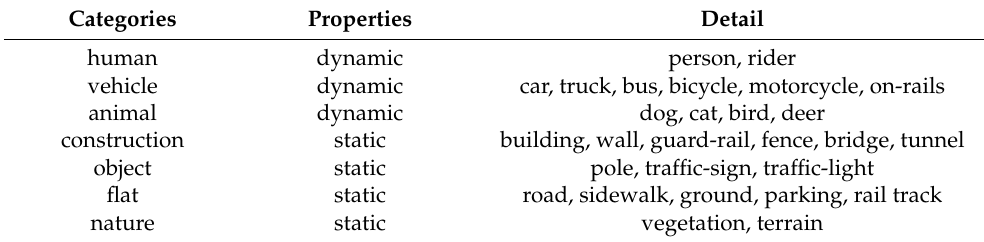
Table 1. Categories of semantic